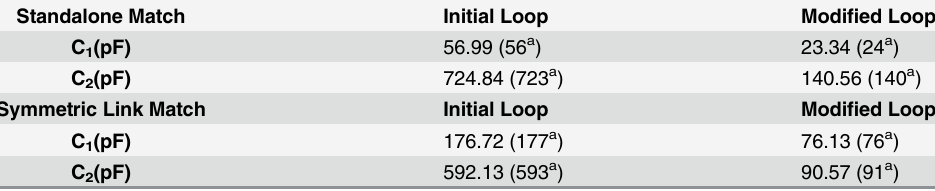
Table 2. Impedance Matching Capacitance Values.